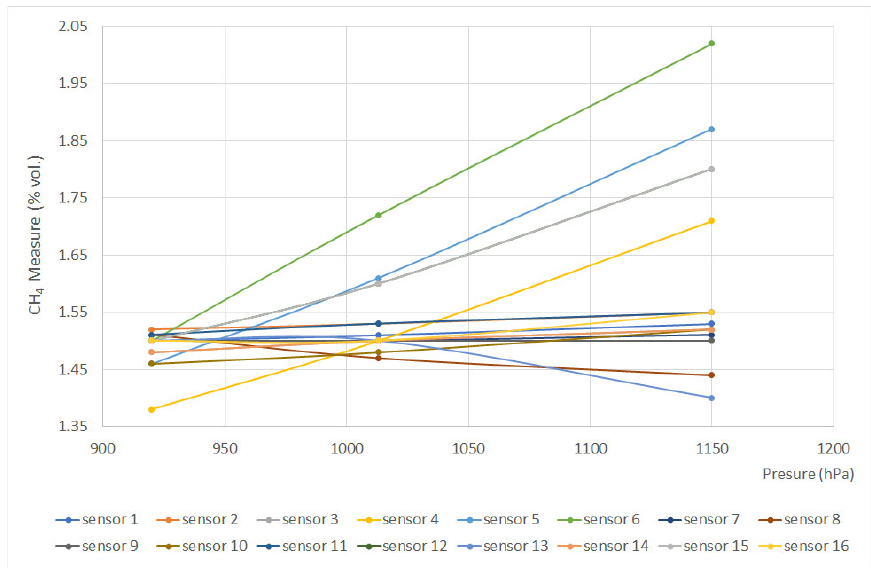
Figure 7. Pressure curves for 1.5% vol.